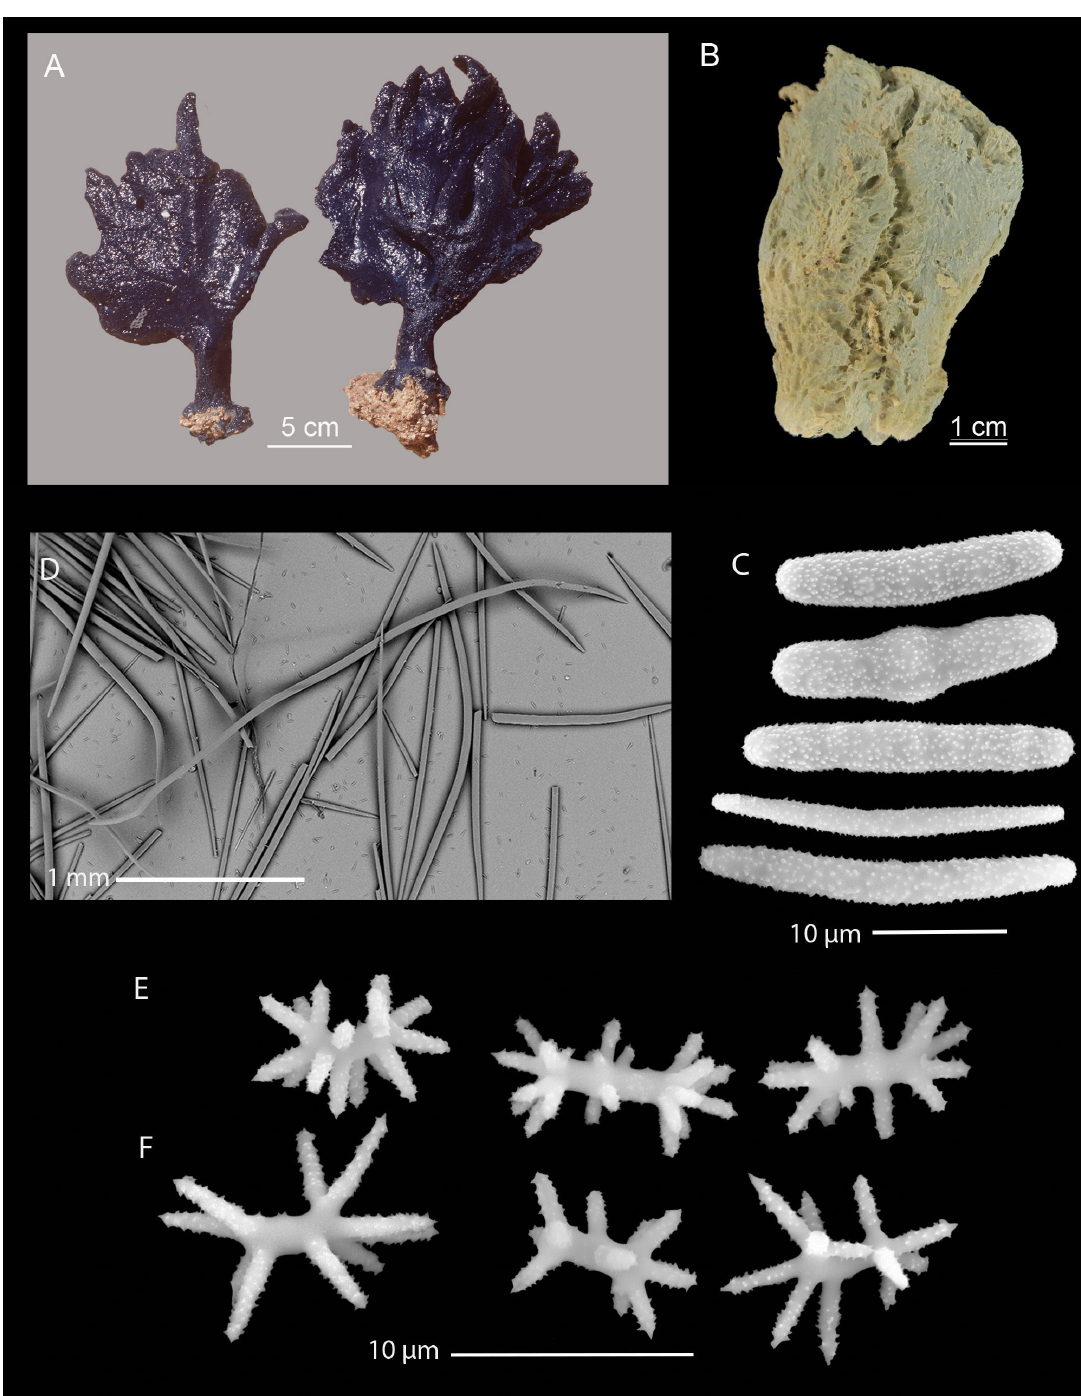
Fig. 2. Morphology, megascleres and microscleres of Lamellomorpha strongylata Bergquist, 1968. A . Deck image showing midnight blue colouration and palmate morphology (NIWA 93474 leg., image Lori J. Bell, CRRF). B . Loss of colouration and radiating skeleton (NIWA 73253 leg.). C . Range of roughened microstrongyles showing centrotylote forms and more typical curved forms (penultimate: NIWA 356 leg., rest: NIWA 93474 leg.). D . Sinuous oxeas (NIWA 93474 leg.). E . Metaster- to amphiaster-like streptasters (left: NIWA 93474 leg., center and right: NIWA 356 leg.); F . Metaster- to amphiaster-like streptasters (left and center: NIWA 356 leg., right: NIWA 93474